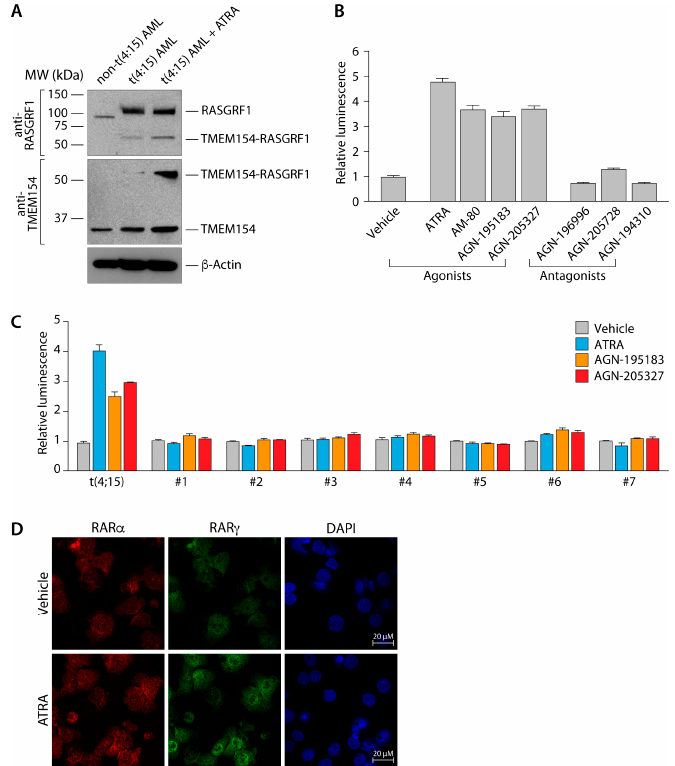
Figure 2. Characterization of t(4;15) AML primary cells. ( A ) Immunoblot analysis of TEM154-RASGRF1 expression. After 72 h treatment, vehicle control non-t(4;15) AML cells (lane 1), vehicle control t(4;15) AML cells (lane 2) and all-trans retinoic acid (ATRA) t(4;15) AML cells (lane 3) were subjected to immunoblot analysis. Samples were probed with rabbit monoclonal antibody against a C-terminal region of RASGRF1 and mouse monoclonal antibody against an N-terminal region of TMEM154. β -actin was used as a loading control. Molecular weight standards (left) and the identities of bands (right) are indicated. ( B ) Proliferation of t(4;15) AML cells in response to retinoids. Cells were treated with vehicle control, ATRA, RAR α agonist (AM-80 or AGN-195183), or RAR γ agonist (AGN-205327). Cells were also treated with RAR α antagonist (AGN-196996), RAR γ antagonist (AGN-205728), or RAR α / β / γ antagonist (AGN-194310). All retinoids were used at a concentration of 1 µ M. Cell proliferation was determined by CellTiter-Glo luminescent cell viability assay (Promega) after 72 h of treatment. Values shown are normalized to vehicle control. ( C ) Proliferation of t(4;15) and non-t(4;15) AML cells in response to retinoid agonists. Samples from t(4;15) and 7 non-t(4;15) AML patients were incubated with vehicle control, ATRA, RAR α agonist (AGN-195183), or RAR γ agonist (AGN-205327) at a concentration of 1 µ M. Cells were analyzed and normalized as described for (B). ( D ) Treatment of t(4;15) cells with ATRA increases levels of nuclear RAR γ . t(4;15) cells were treated with vehicle control or 1 µ M ATRA and incubated for 72 h before staining with RAR α mouse monoclonal and RAR γ rabbit polyclonal